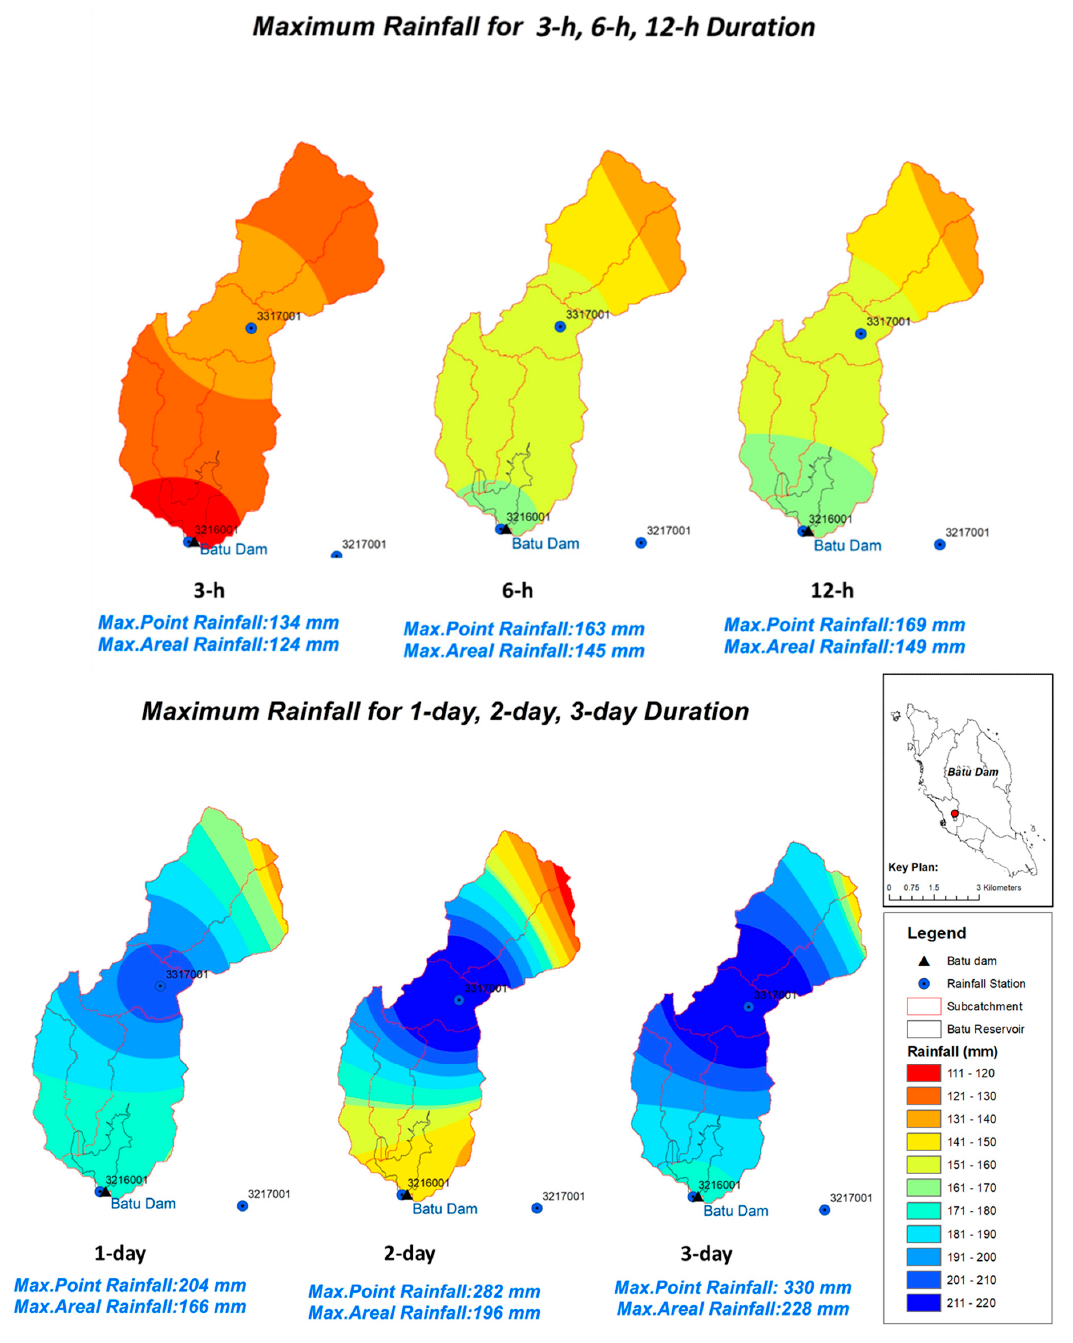
Figure 10. Isohyets Map for the recorded rainfall (extreme events) in mm different durations. Table 3. Probable maximum precipitation (PMP) estimation of Batu